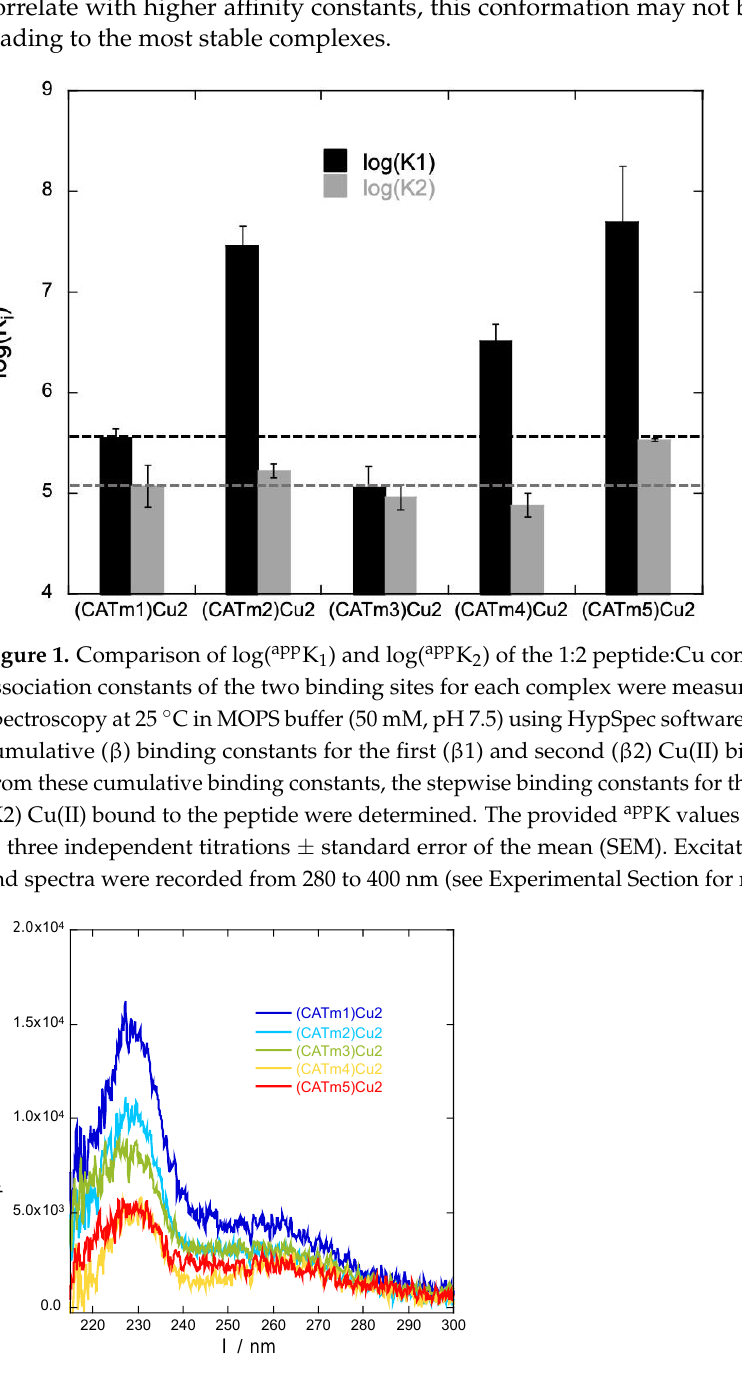
Figure 2. Circular dichroism spectra normalized by the number of residues within each peptide of CATmx:Cu 1:2 mixtures ([CATmx] = 133 µM, x = 1 – 5). Spectra were recorded at 20 °C in MOPS buffer (50 mM, pH 7.5).